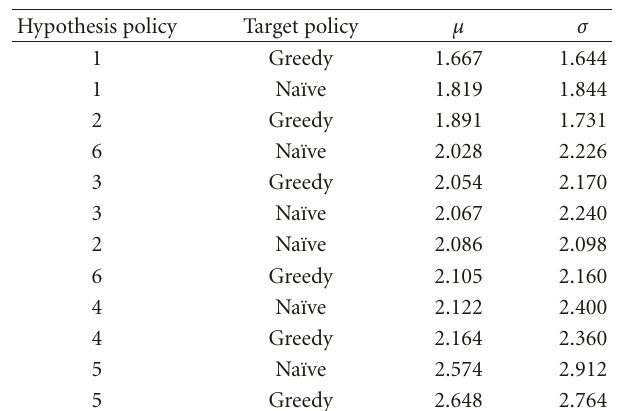
Figure 3: Tracking objects with the greedy policy. Example run of the one-dimensional simulation showing the positions of three objects being tracked with the greedy policy. Only 100 timesteps out of 500 are shown for clarity. For each object, “x” marks the target’s estimated position. The most dynamic object (bottom in red) is tracked 52% of the time, the second most dynamic (middle in green) is tracked 33% of the time, and the least dynamic (top in blue) is tracked 15% of the time. Table 2: Mean error and std dev for all 12 cases evaluated over 10,000 trials in simulation. The policy combinations are sorted with the least error on top and the largest error on bottom. The first column represents the hypothesis selection policy, as described in Table 1, and the second column represents the target tracking policy.